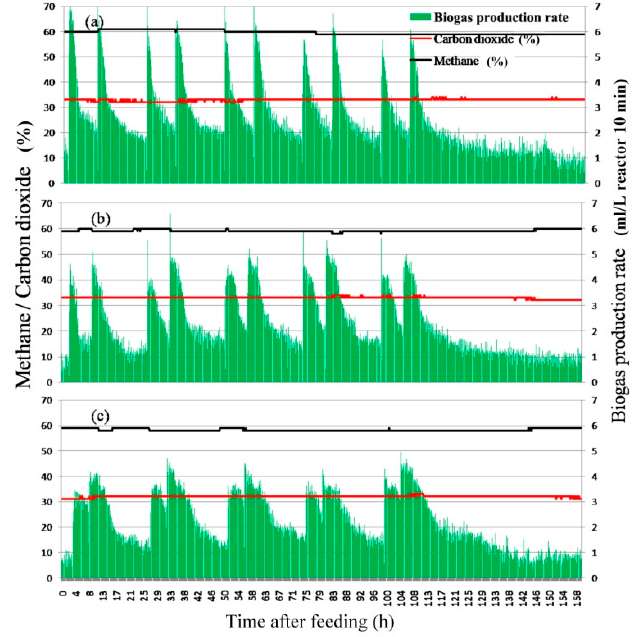
Figure 3. Experimental results of biogas production with feeding twice per day, feeding OLR = 0.95 g COD L − 1 digester day − 1 : ( a ) 9 h feeding time interval; ( b ) 7 h feeding time interval; ( c ) 5 h feeding time interval.